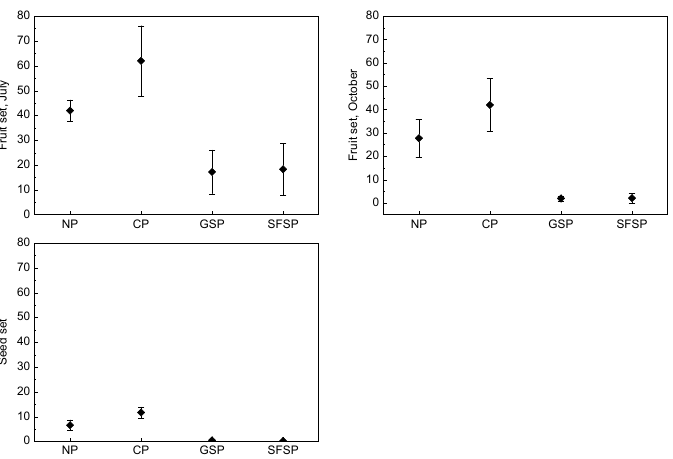
Figure 3. The effect of pollination treatments on the fruit and seed set of Schima superba (S.E.). Note: NP, open-pollinations; CP, cross-pollination; GSP, geitonogamous self-pollination; SFSP, self-pollination with the same flower.